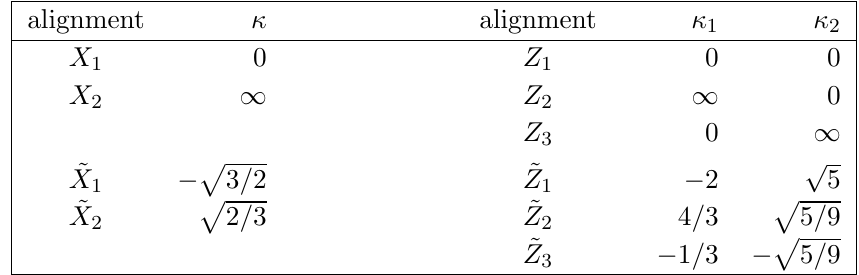
Table 6 . The special values of ratios (cid:20) , (cid:20) 1 and (cid:20) 2 corresponding to discrete VEV alignments in the representations 45 and 210